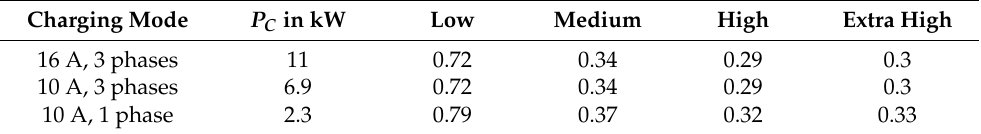
Table 10. WLTP energy consumption in kW · h 2 for the Kia e-Niro.